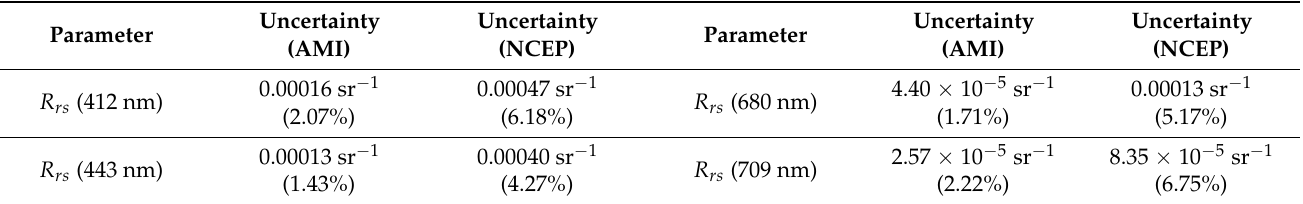
Table 3. Comparison of estimated uncertainty values for ocean-color products obtained using advanced meteorological imager (AMI) and National Centers for Environmental Prediction (NCEP) TPW data.